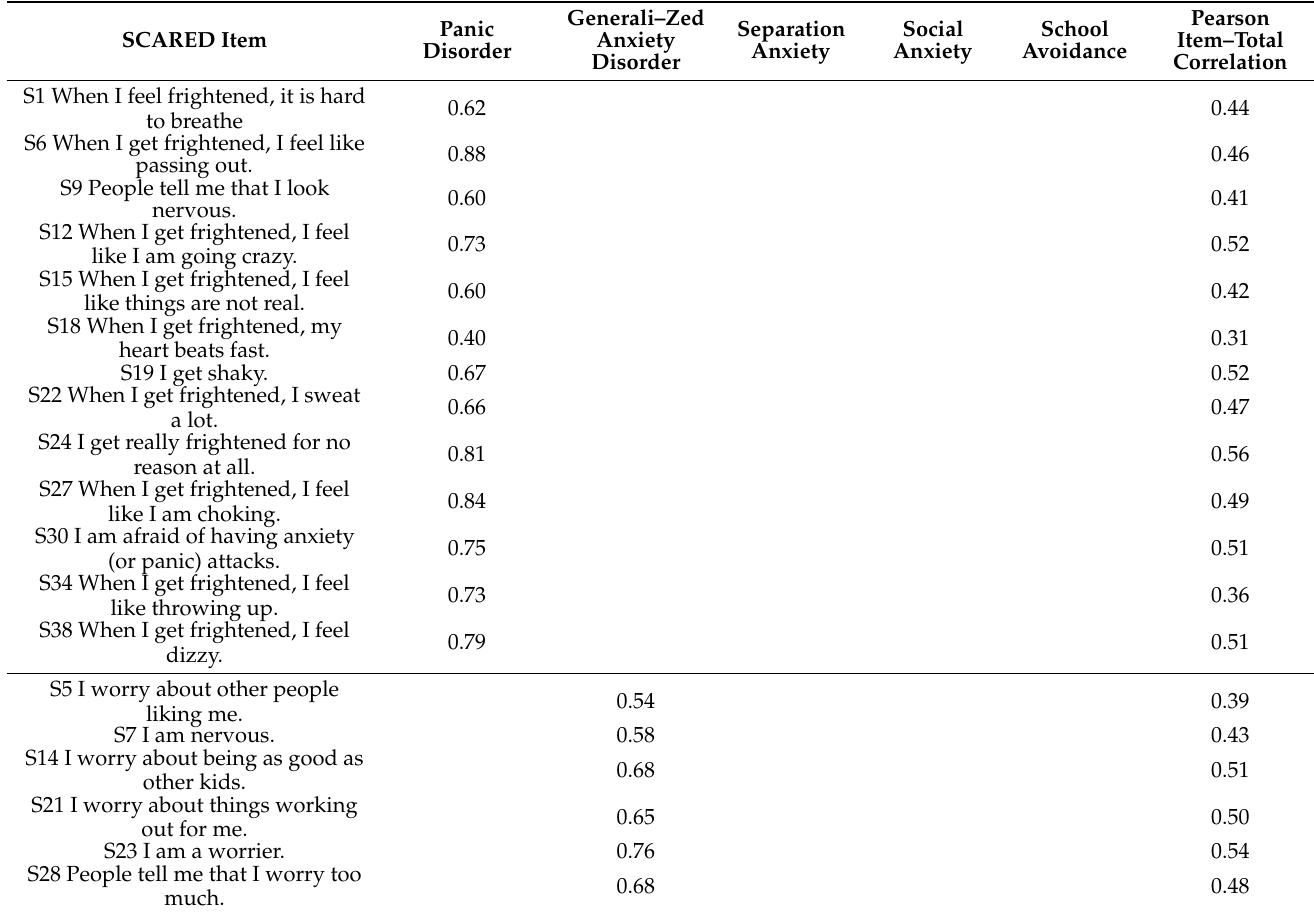
Table 4. Factor loadings and factor internal consistency (n =